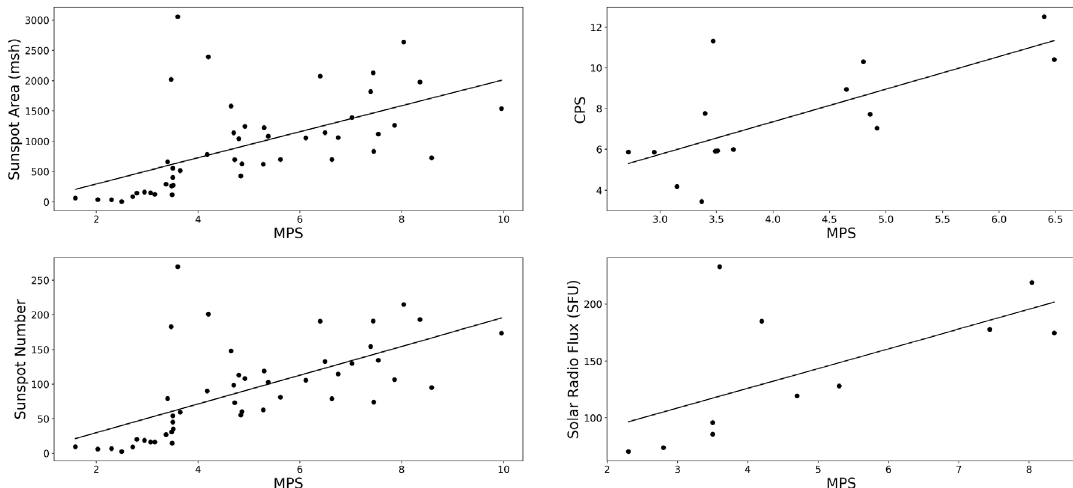
Figure 4. Comparison between the Madrid annual prominence series (MPS) and (top-left panel) the sunspot area series by Mandal et al. (2020), (top-right panel) daily mean of the prominences number recorded at the Astronomical Observatory of the University of Coimbra by Carrasco & Vaquero (2022), (bottom-left panel) the sunspot number index (version 2) and (bottom-right panel) solar radio fl ux at 10.7 cm. Black lines depict the best linear fi t between the datasets.